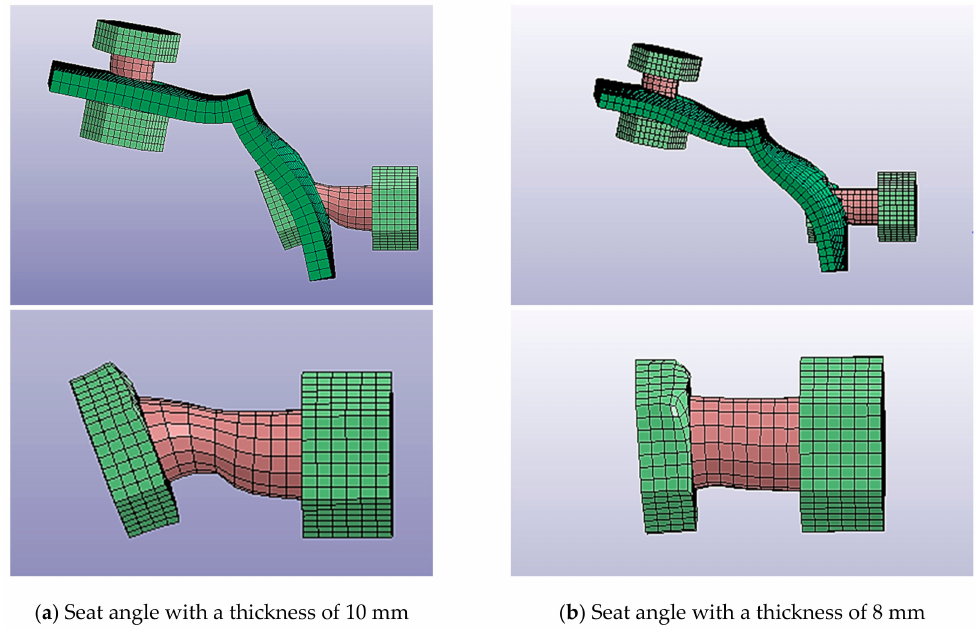
Figure 16. Failure modes of the bolted seat angles.